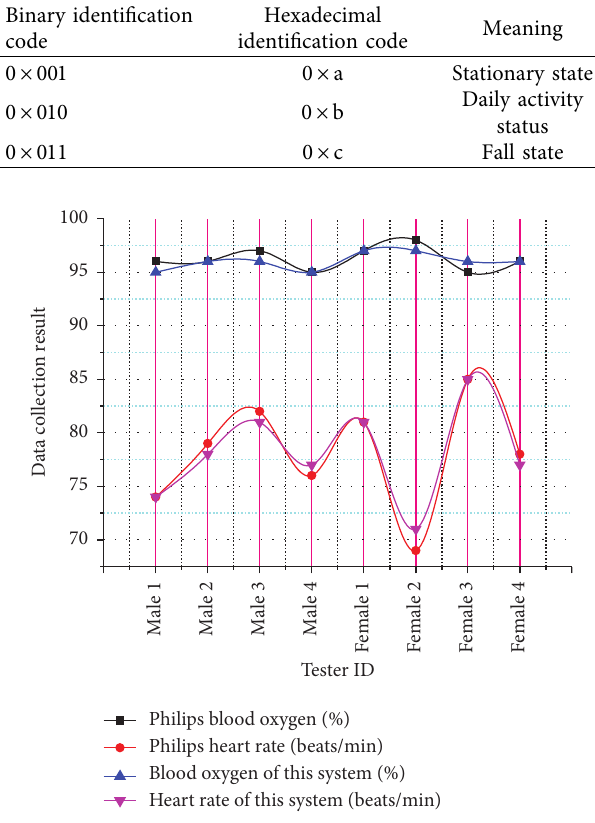
Figure 2: Comparison of blood oxygen and heart rate collection data.